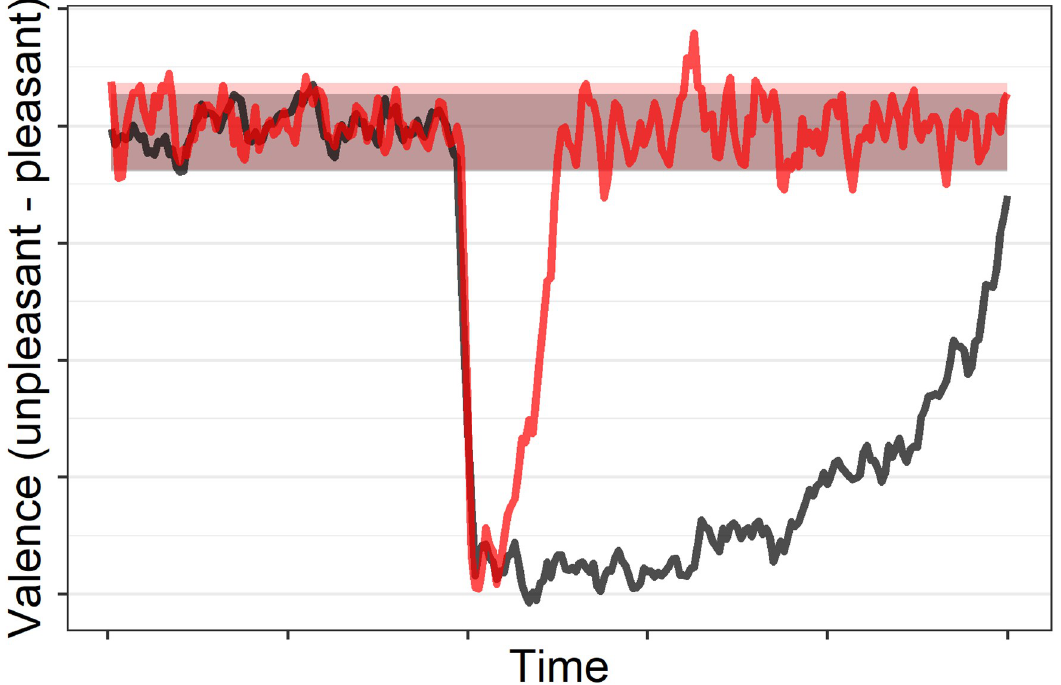
Fig 2. Change in valence over time for two hypothetical (simulated) people (black and red). The black line depicts a much slower recovery rate than the red line.